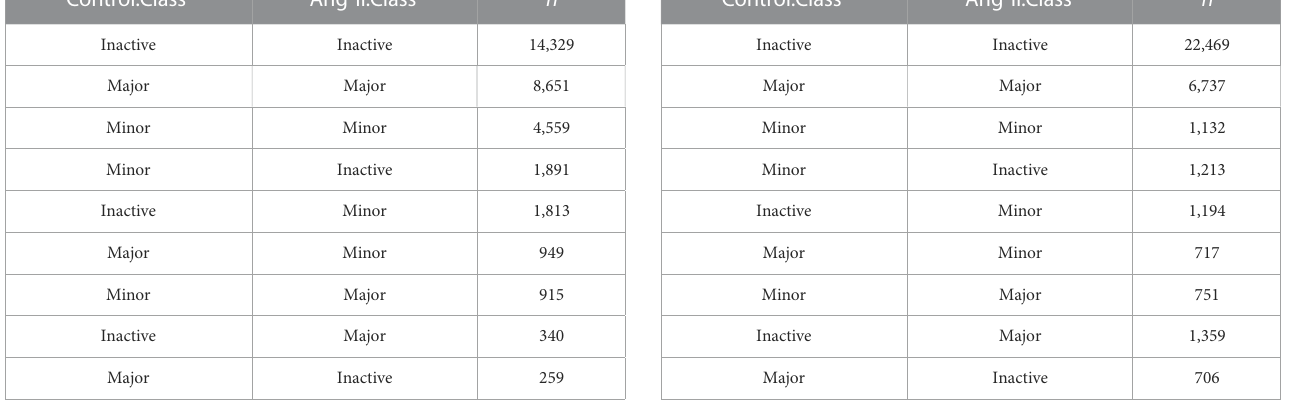
TABLE3StateofisoformchanginginControlandAngII(RNA-seqquanti fi cation).